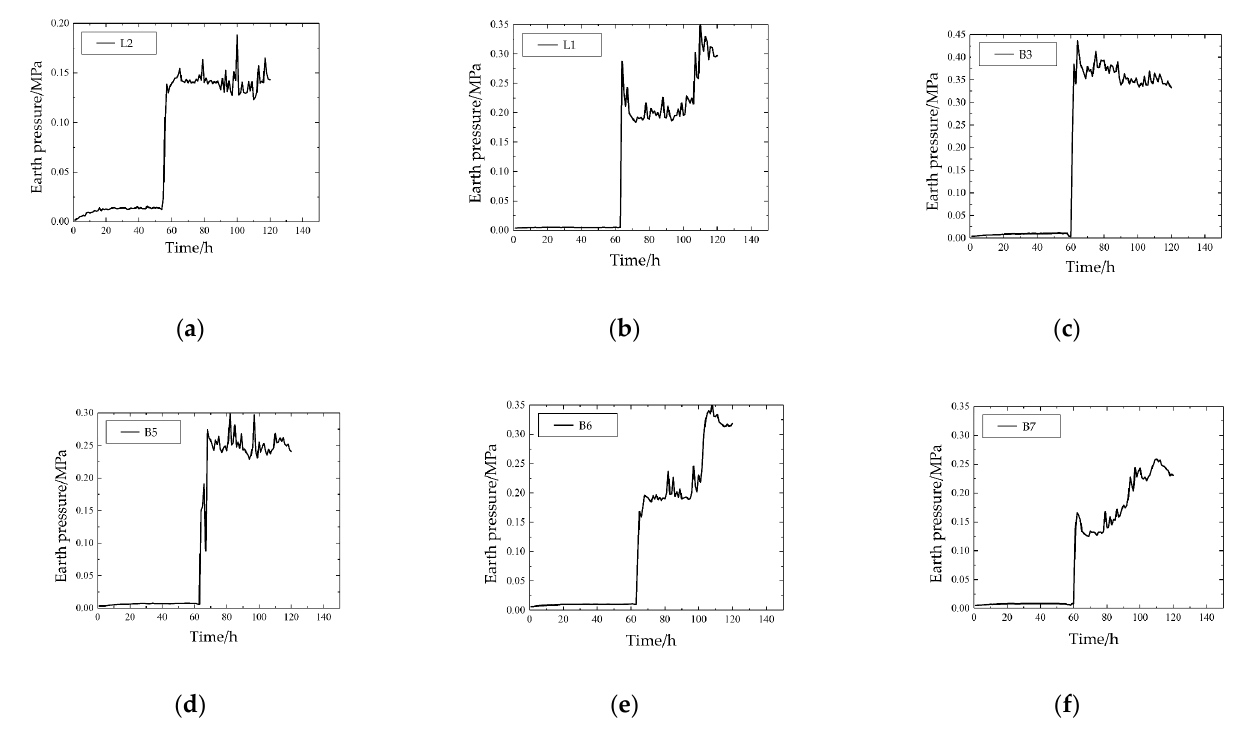
Figure 9. Variation of earth pressure outside the segment with time: ( a ) L2; ( b ) L1; ( c ) B3; ( d ) B5; ( e ) B6; ( f )